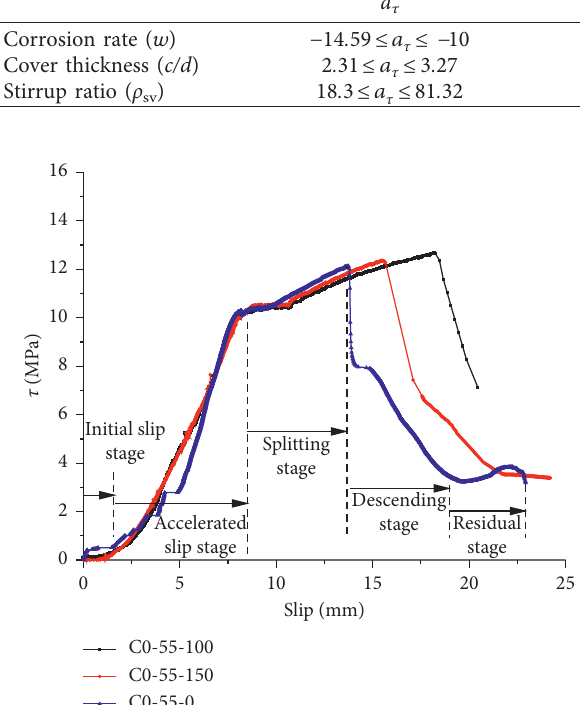
Figure 5: The bond-slip curves of C0-55- s